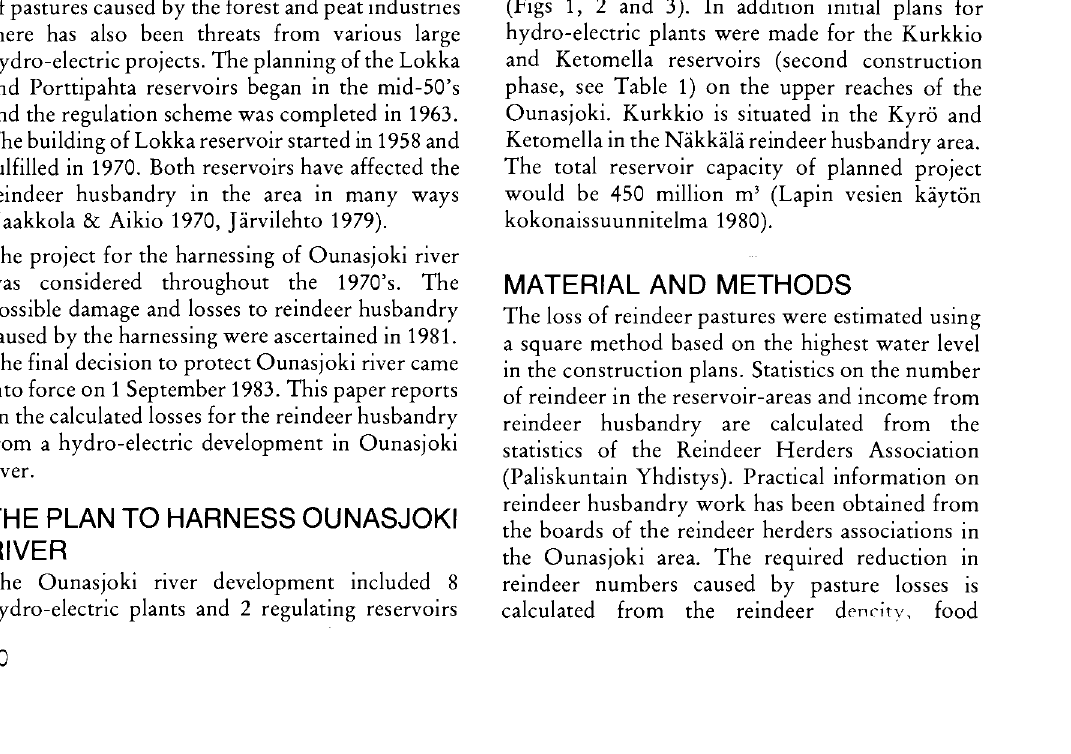
Fig. 1. Ounasjoki river Bild 1. Ounasjoki